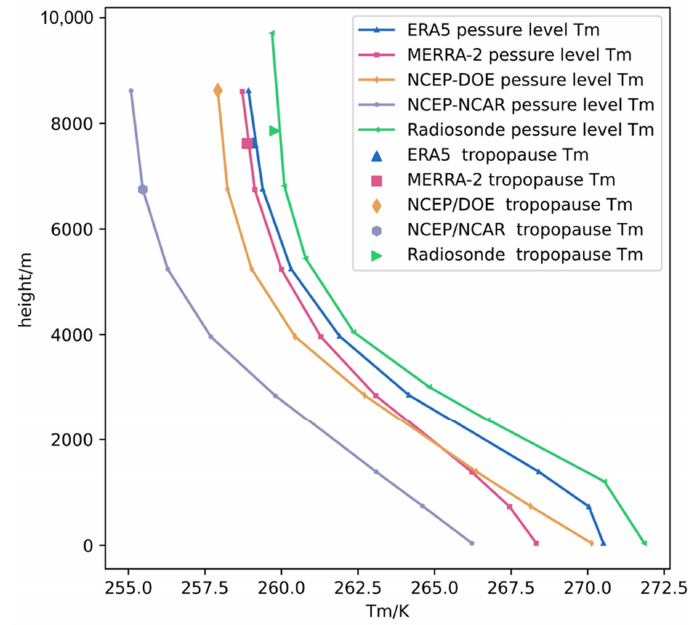
Figure A1. T m derived from four reanalysis and radiosonde data under different heights (ground height of the station, 925, 850, 700, 600, 500, 400, and 300 hPa) and the